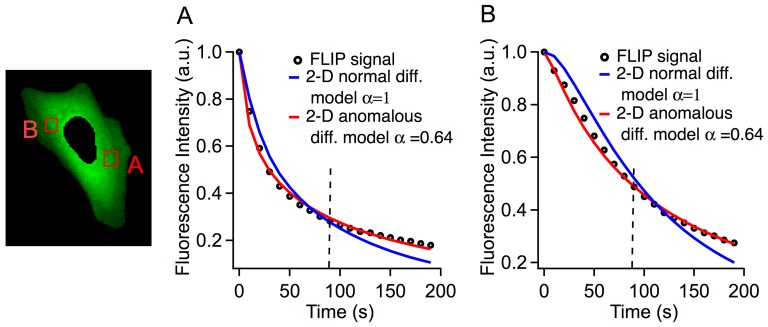
Comparison of experimental data with 2-D normal and anomalous diffusion models at the two locations in the cell (A) and (B).The experimental fluorescence intensity (black circles) initially decays faster, and subsequently slower than the best normal diffusion model fits (blue curves). Only anomalous diffusion with α<1 (red curves) correctly simulates the observed data. The vertical dashed lines at 85 s indicate where the short time (horizontal axis in Figure 4) and long time (vertical axis in Figure 4) residuals were calculated. The normal diffusion model tends to have a negative residual at short time and a positive residual at long time, whereas the anomalous diffusion model has much smaller residuals.